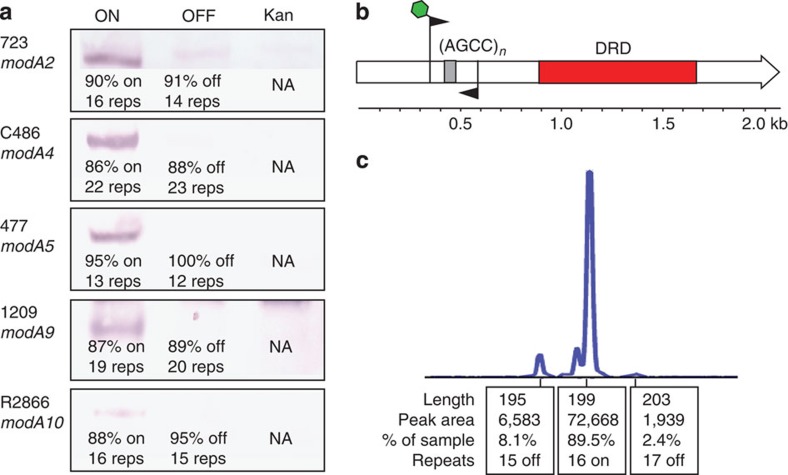
Western blots showing ModA presence in modA ON OFF and kanamycin knockout strains and an example of the fragment analysis methodology.(a) Western blot analysis using ON/OFF/kan cells from all the five modA alleles; anti-modA primary antibody at 1:5,000; AP conjugated anti-rabbit secondary at 1:20,000. A modA band is only present in those cells possessing the ON variant of each strain. The number of repeats (reps) represents the major number of repeats present in that particular isolate, and the percentage ON of that particular strain is noted underneath each relevant blot. Full western blots are presented in Supplementary Fig. 4; (b) an illustration of the methodology used during fragment analysis to ascertain modA ON/OFF state and percentages of cell populations. A 6-carboxyflourescein (FAM)-labelled forward primer (green hexagon) and unlabelled reverse primer was used to generate a PCR product over the repeat tract (AGCCn; grey box) that was analysed using GeneScan technology; and (c) an example trace produced by GeneScan analysis on a representative genomic sample from an NTHi strain containing a phase variable modA gene.